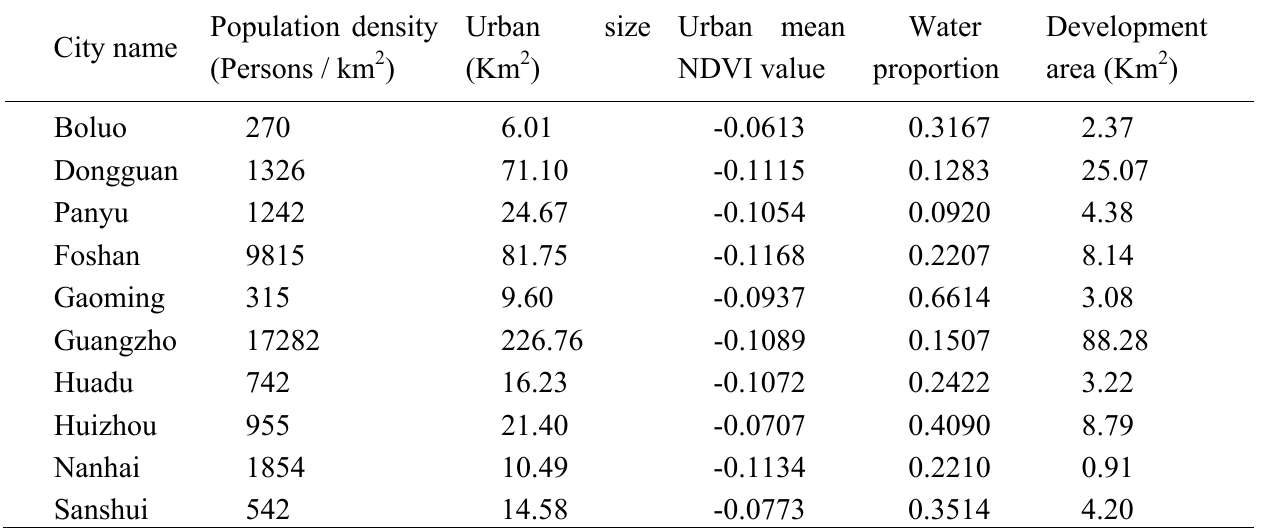
Table 1. Factors extracted from the classification image and mean NDVI 1)